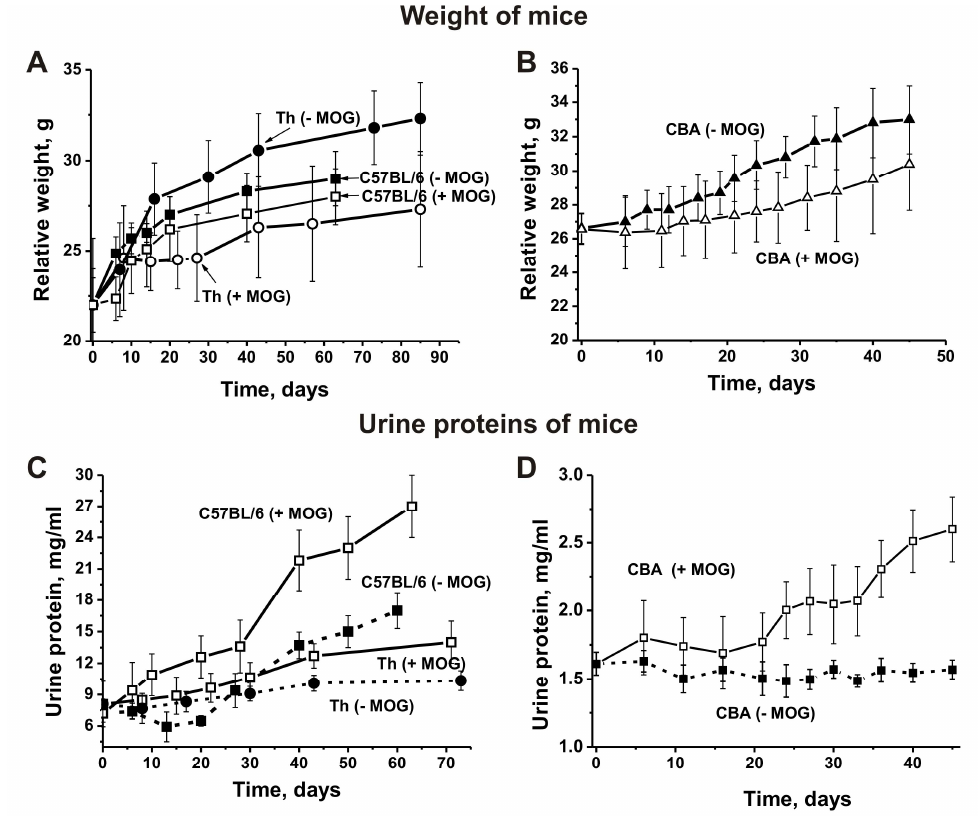
Figure 1. Relative changes in body weight over time characterize EAE-prone C57BL / 6, Th ( A ), and CBA ( B ) mice before and after their immunization with myelin oligodendrocyte glycoprotein (MOG). Additionally, changes in proteinuria over time characterize EAE-prone C57BL/6, Th ( C ), and CBA ( D ) mice before and after their immunization with MOG.